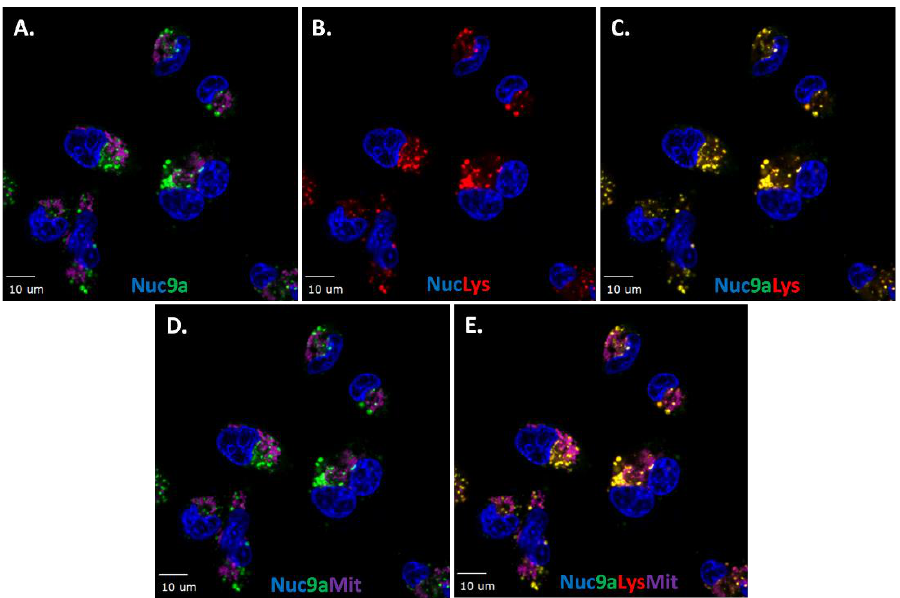
Figure 7. Representative images of co-localization studies of probe 9a with organelle fluorescent trackers in live MDA-MB-231 cells. A. Hoechst nuclear stain (blue) and probe 9a (1 µ M, green). B. Lysosome tracker (red) and nuclear stain (blue). C. Merge of probe 9a , lysosome and nuclear stains. D. MitoTracker Deep Red (purple), nuclear stain (blue) and compound 9a (green). E. Nuclear stain, probe 9a , Lysosome (red) and MitoTracker Deep Red. Scale bar: 10 µ m.